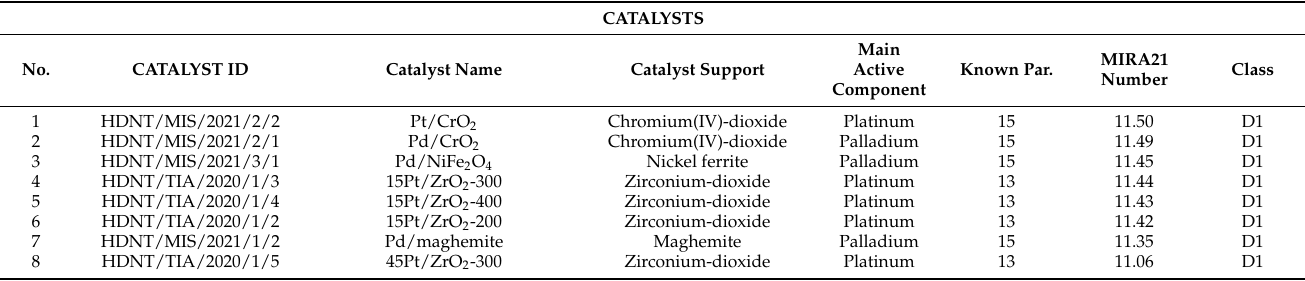
Table 3. Catalysts for dinitrotoluene hydrogenation to toluenediamine in liquid phase [14,16,40,44– 55].